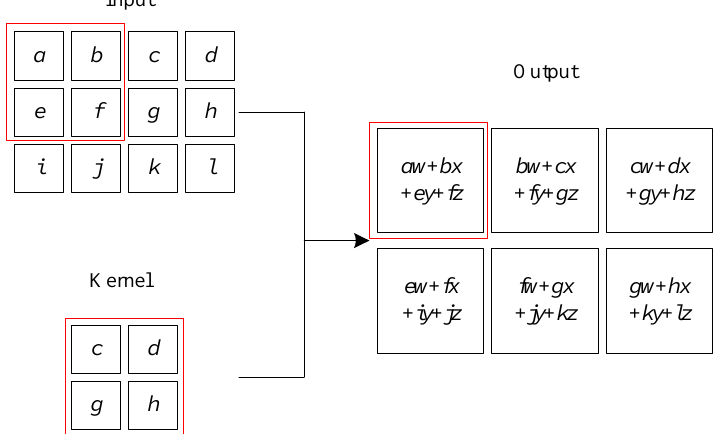
Figure 10. An example of two-dimensional convolution.